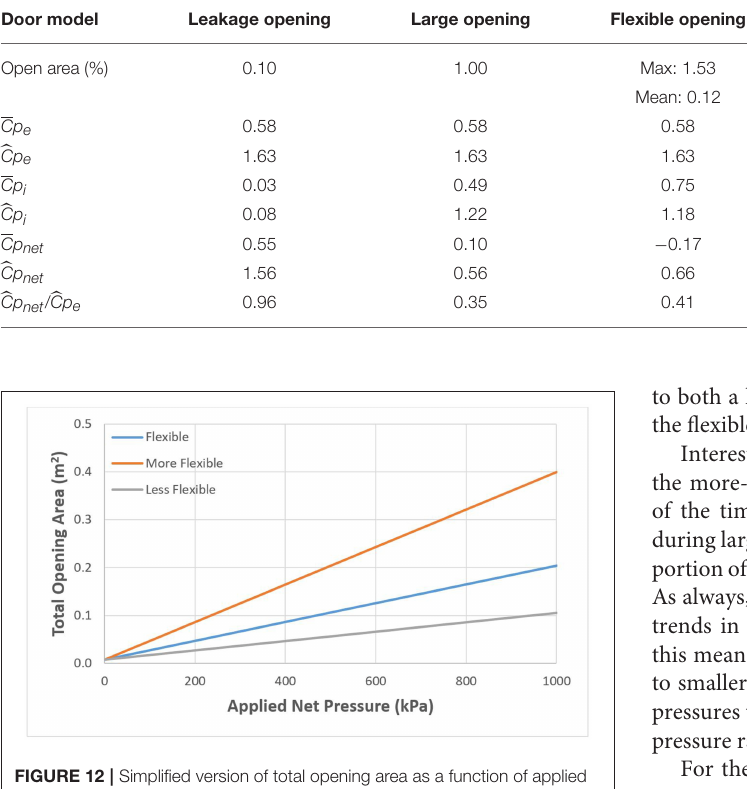
FIGURE 12 | Simplified version of total opening area as a function of applied net pressure for the three flexible opening